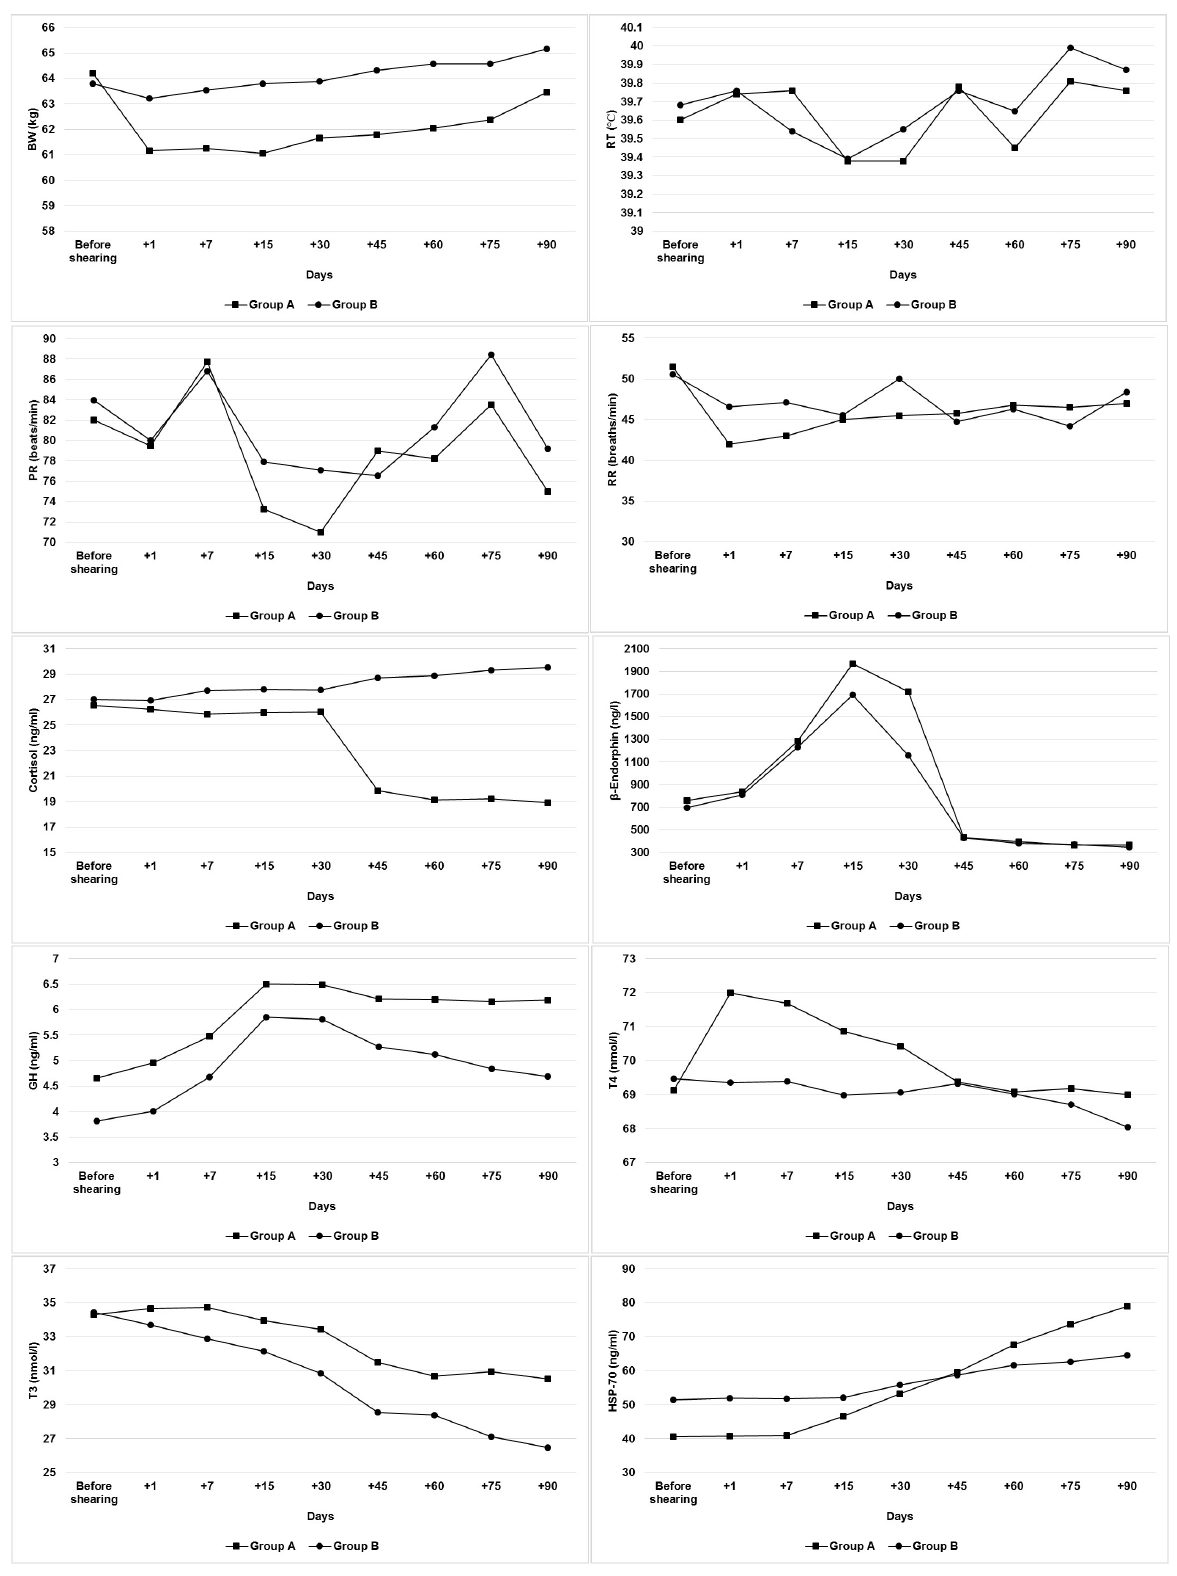
Figure 1. The patterns of BW, RT, PR, RR, cortisol, β -endorphin, GH, T group; BW, body weight; RT, rectal temperature; PR, pulse rate; RR, respiratory rate; GH, growth hormone; T Sampling was before shearing (–1 day) and on days +1, +7, +15, +30, +45, +60, +75, and +90 following the